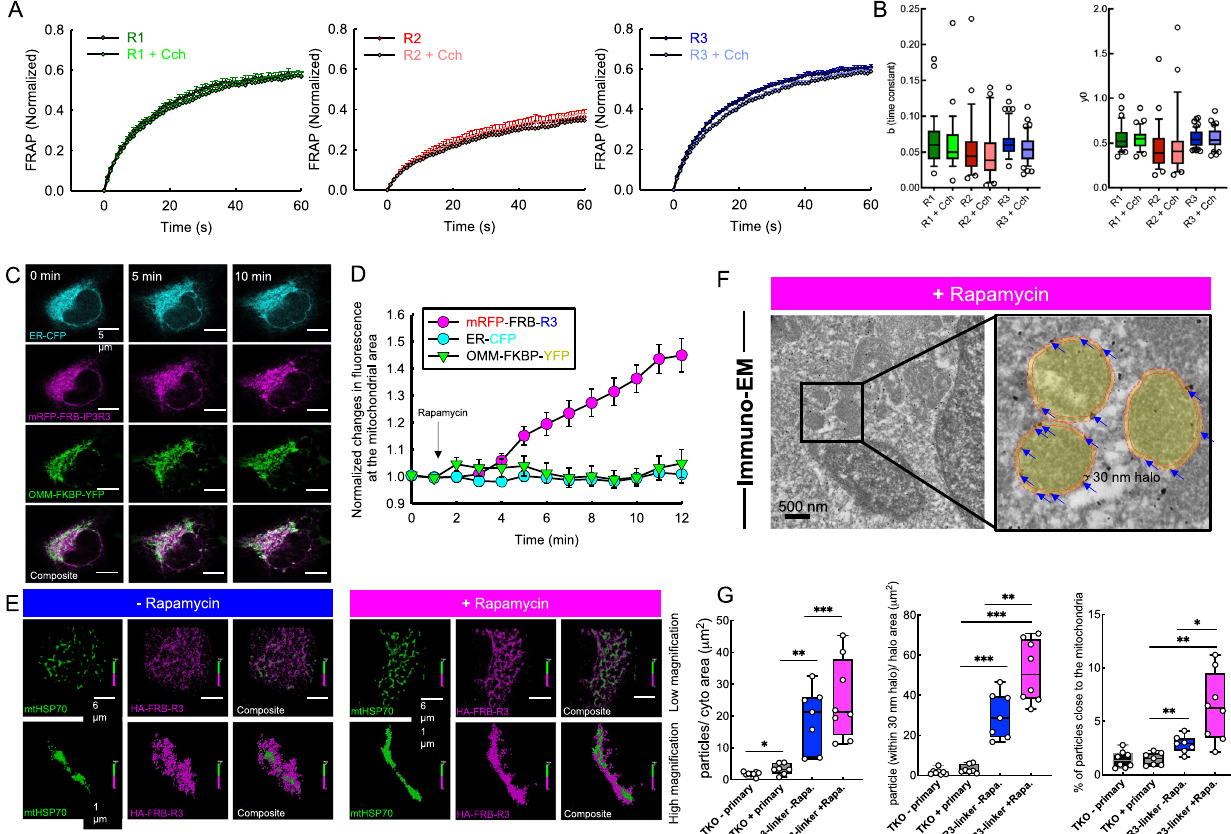
Fig.3|LateralmobilityofIP3RsallowstheirtrappingatERMCs.A Averagetime courses showing IP3R-mRFP fl uorescence recovery after photobleaching normal- ized to the pre-bleach intensity in unstimulated R1 (green), R2 (maroon), and R3 (blue) and Cch stimulated R1 (light green), R2 (light red) and R3 (light blue) acute TKO rescue cells (datapoints represent averages with ±SEM, (R1 n =32, R1+Cch n =37, R2 n =37, R2+Cch n =23, R3 n =55, R3+Cch n =43 from three experi- ments). B Calculated time constant and recovery (y0) for each IP3R isoform with and without agonist stimulation (R1 n =32, R1+Cch n =37, R2 n =25, R2+Cch n =23, R3 n =55, R3+Cch n =43 from three experiments; Unpaired t -test; Two- tailed p value;b:R1vsR1+Cch p =0.4819,R2vsR2+Cch p =0.4494,R3vsR3+Cch p =0.0585; y0: R1 vs R1+Cch p =0.7404, R2 vs R2+Cch p =0.7596, R3 vs R3+Cch p =0.9114, Box plots indicate median, 25th and 75th percentile (box), and 5th and